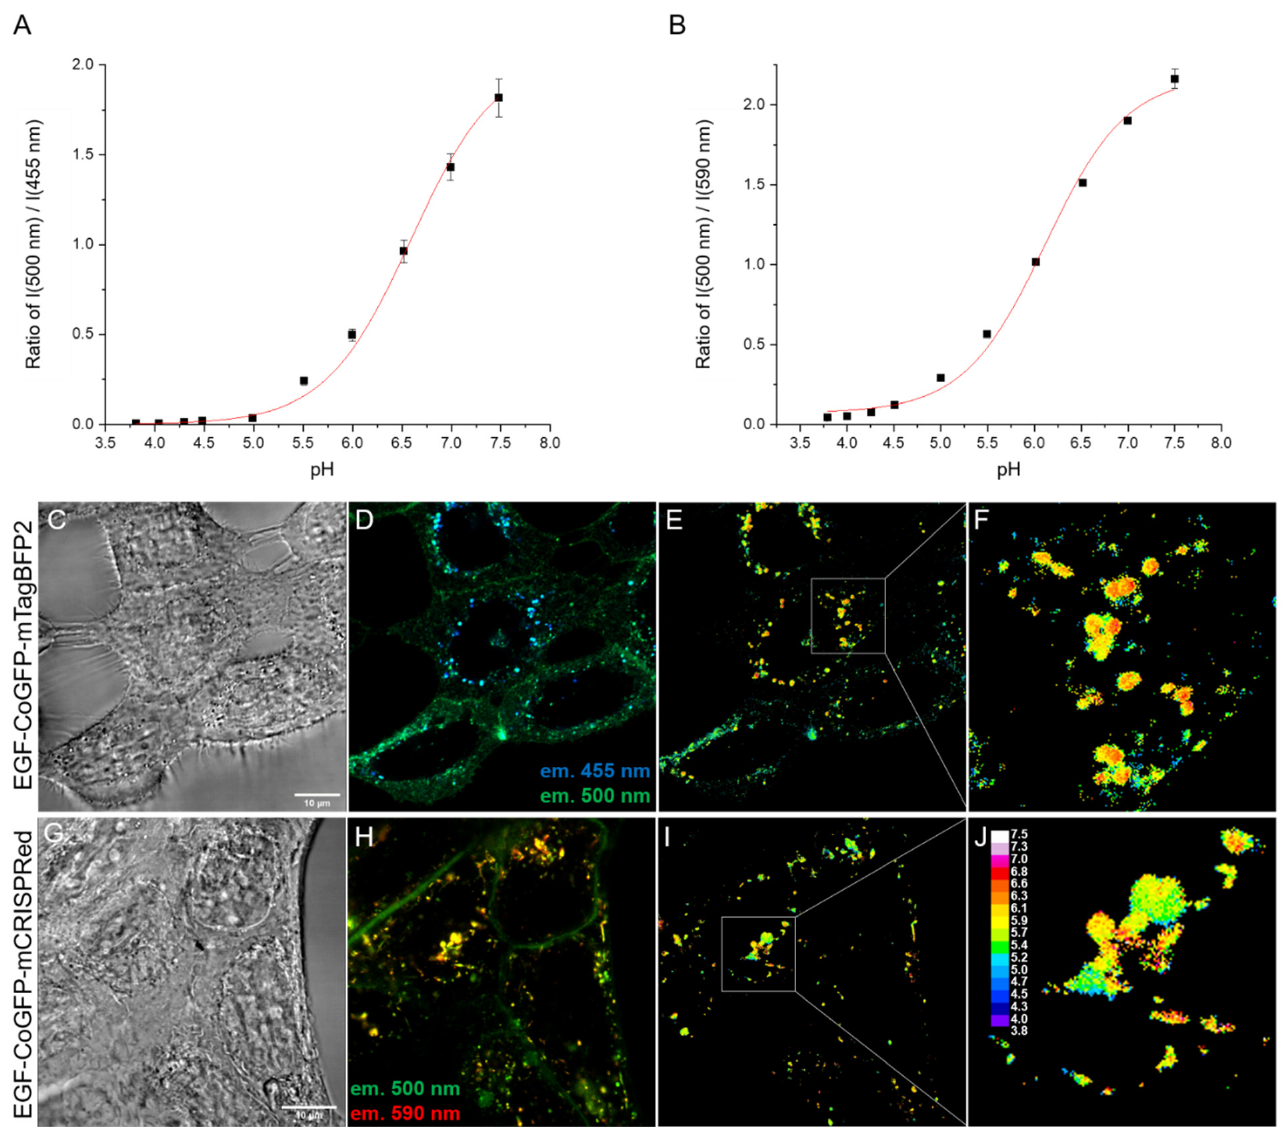
Figure 4. Fluorescence measurements of titrated ( A ) EGF-CoGFP-mTagBFP2 or ( B ) EGF-CoGFP- mCRISPRed protein solutions were performed using confocal microscopy, and mean values of emission ratios of intensities at 500 nm (ex. 488 nm)/455 nm (ex. 405 nm) or 500 nm (ex. 458 nm)/590 nm (ex. 458 nm) were calculated. Mean values of ratios were obtained from processed images using ImageJ software [47]. Data points were fitted according to Equation (1) using OriginPro software. Error bars represent the standard deviation. A431 cells expressing high levels of EGFR were incubated with 100 nM ( C – F ) EGF-CoGFP-mTagBFP2 or ( G – J ) EGF-CoGFP-mCRISPRed for 10 min, washed, further incubated for ( A ) 1 h or ( B ) 8 h at 37 ◦ C, and imaged using confocal fluorescence microscopy. ( C , G ) Scale bars in the lower right corner of the bright-field images represent 10 µ m. Pixel-to-pixel intensity ratios ( D , H ) were converted with the corresponding calibration curve into pH values ( E , I ). The resulting intracellular pH maps were pseudo-colored according to the calibration bar. White boxes indicate selected areas for ( F – J ) image